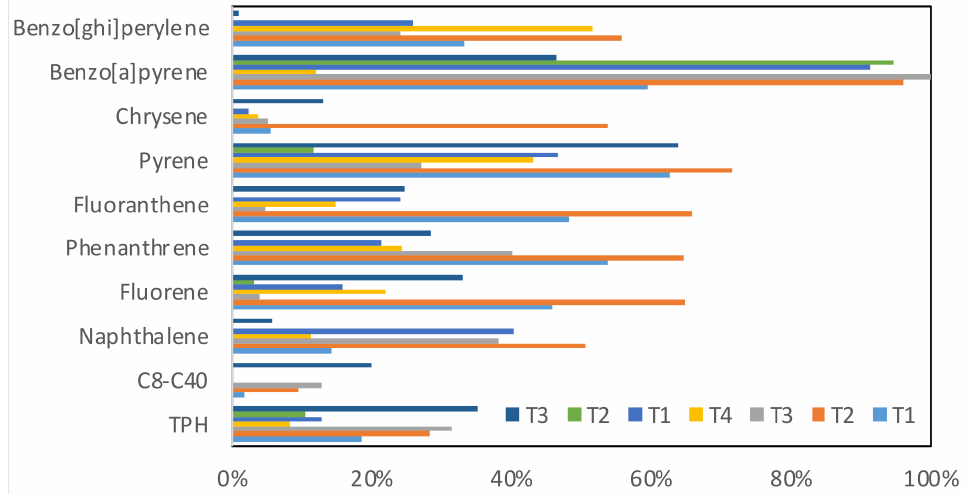
Figure 3. Pollutant removal percentage. T1, T2, and T3: soils treated with lime at 1, 2, and 3%, respectively; T4, T5, and T6: soils treated with 40 nm silica nanoparticles at 0.5, 1, and 2%, respectively; T7: soil treated with 0.5% nanosilica and 2%